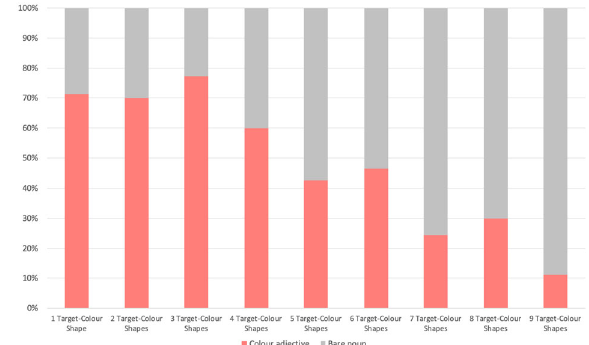
Fig. 7 Percentage of redundant color adjectives and bare nouns as a function of target-color discriminability. Target-color discriminability ranged from maximal (one Target-Color Shape: the target has a unique color) to zero (nine Target-Color Shapes: all nine shapes are the same color as